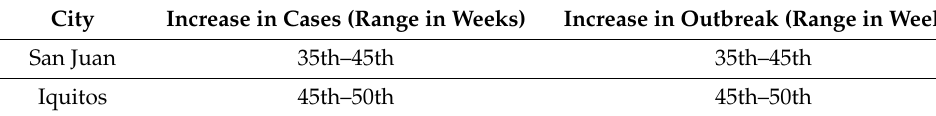
Table 5. Increase in outbreaks and cases in two cities (San Juan/Iquitos) in weeks.